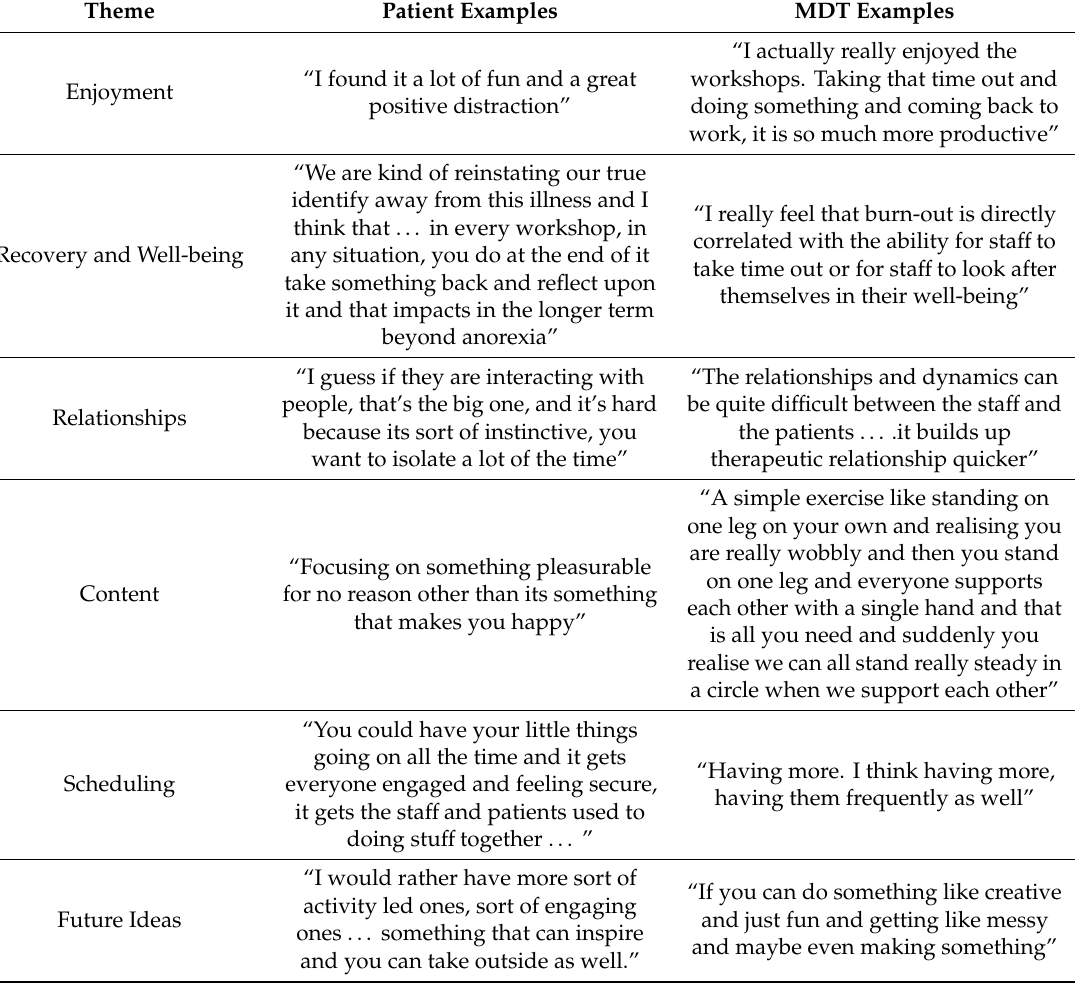
Table 3. A table of qualitative examples for each theme for the MDT and patient groups.